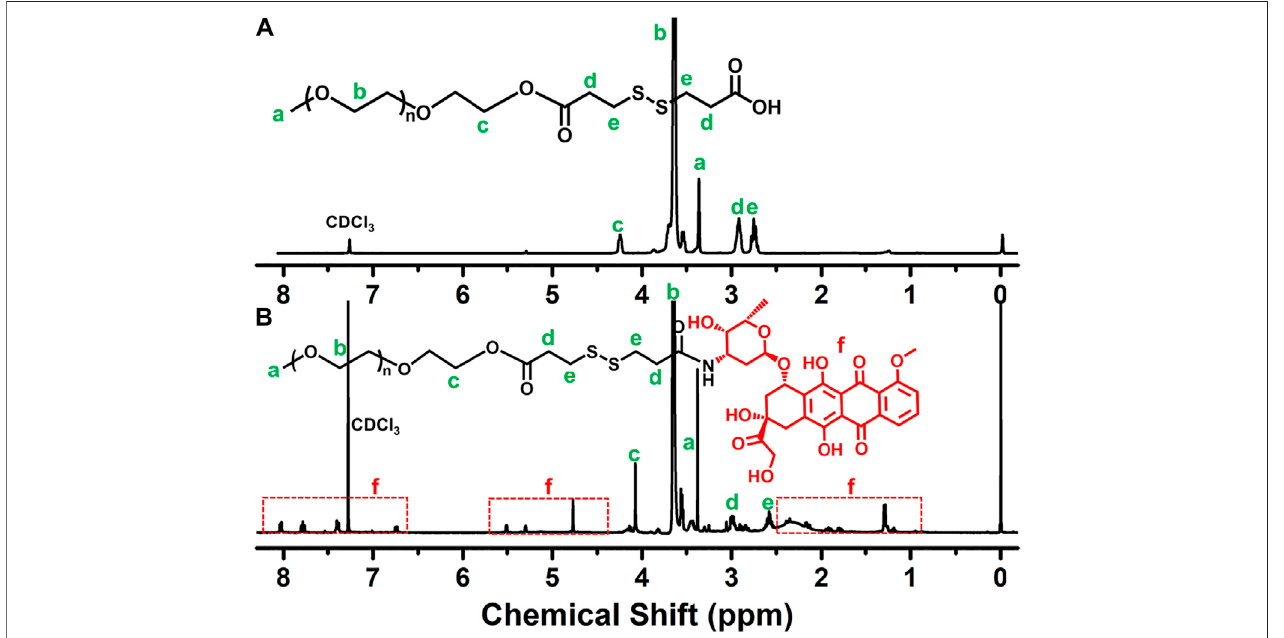
FIGURE 2 | 1 H NMR spectra of (A) PEG – SS – COOH and (B) PEG – disul fi de – DOX polymers. The shift peaks and the intricate peaks of DOX components verify the polymeric